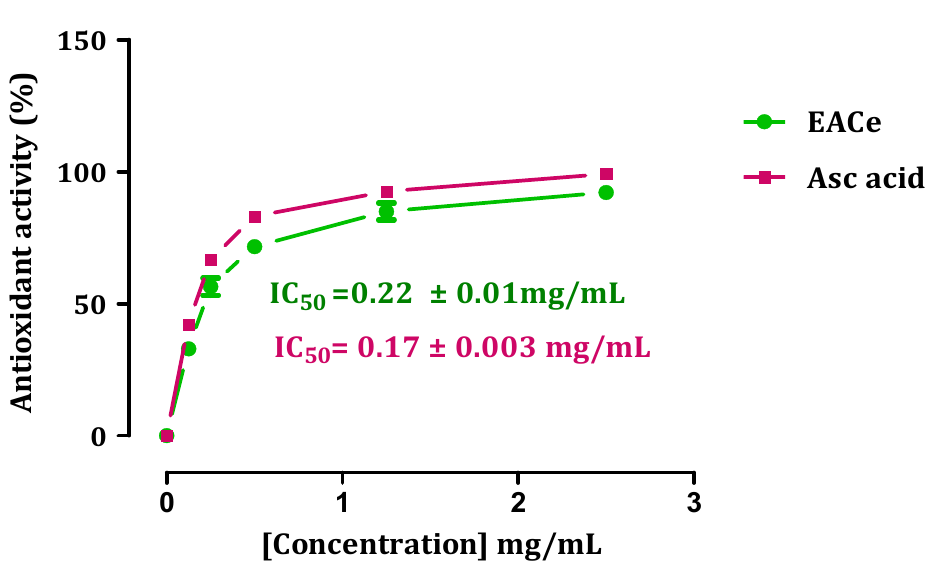
Figure 1. DPPH-scavenging activity of ethyl acetate fraction of C. europaea (EACe). Each value is expressed as mean ± SEM ( n = 3).